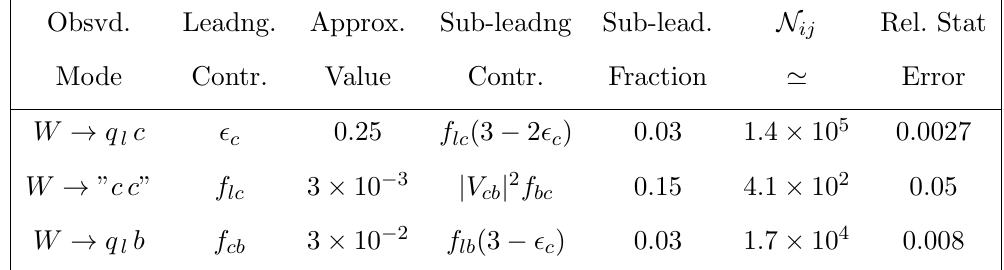
Table 3 . Summary of usable calibration channels. The statistical uncertainties in the last column are calculated assuming the Run 2